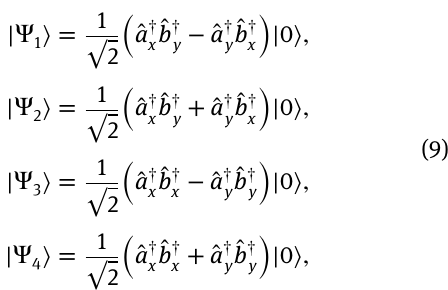
Figure 4: Simulation results of the far-filed transmission spectra excited by a normally incident light with E the pixels  ,  ,  ′ , and  ′ . The output light is divided into − 1 order and + 1 order in the far-field. For the pixels  ,  ,  ′ , and  ′ , the output light beams in + 1( − 1) order are E E ( − i E ), x y